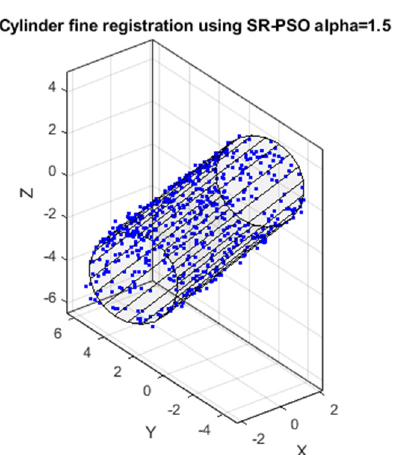
Figure 5. The best final registration.